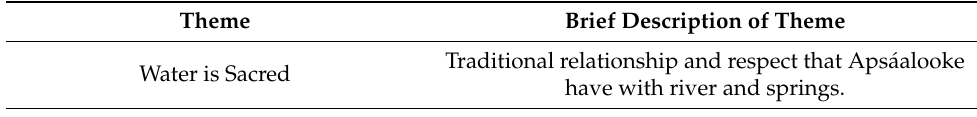
Table 2. Themes and their descriptions resulting from qualitative